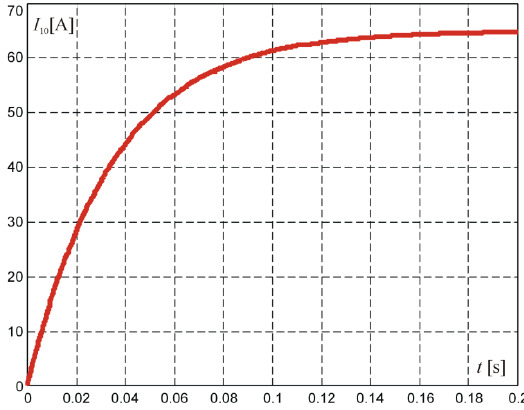
Figure 5. Current curve at the input of the two ‐ port network.